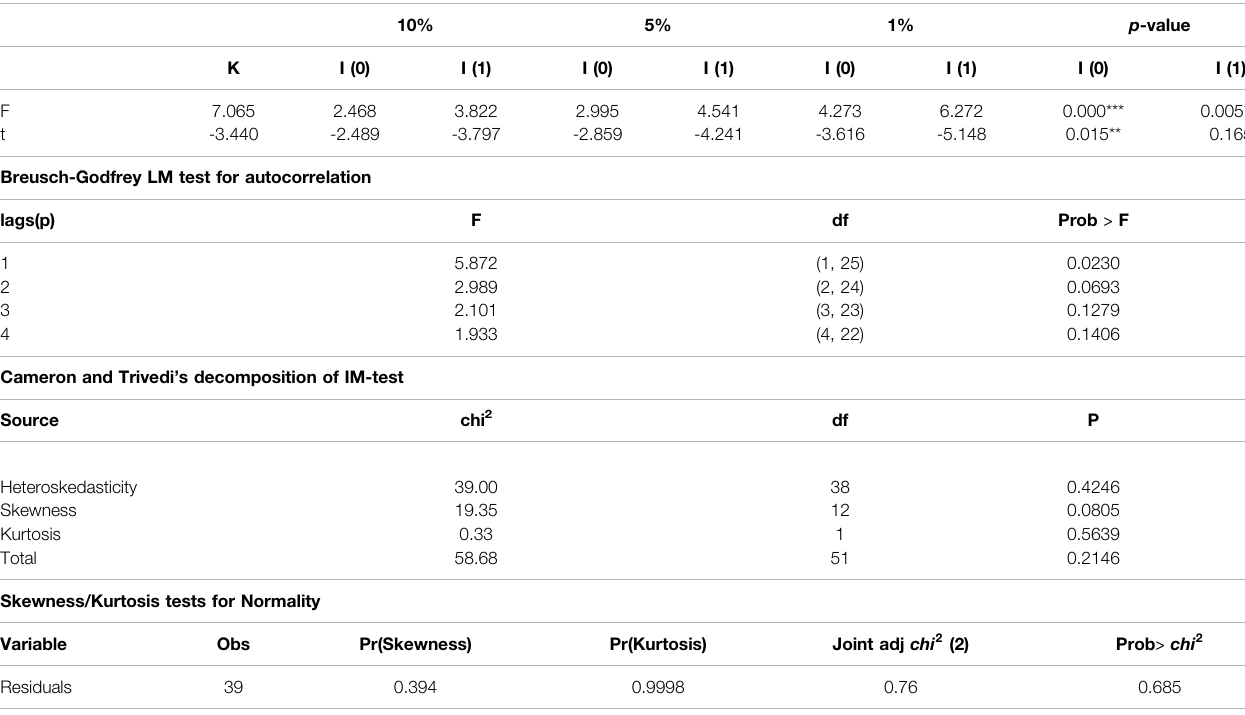
TABLE 4 | Stability tests results. Pesaran, Shin, and Smith Bounds